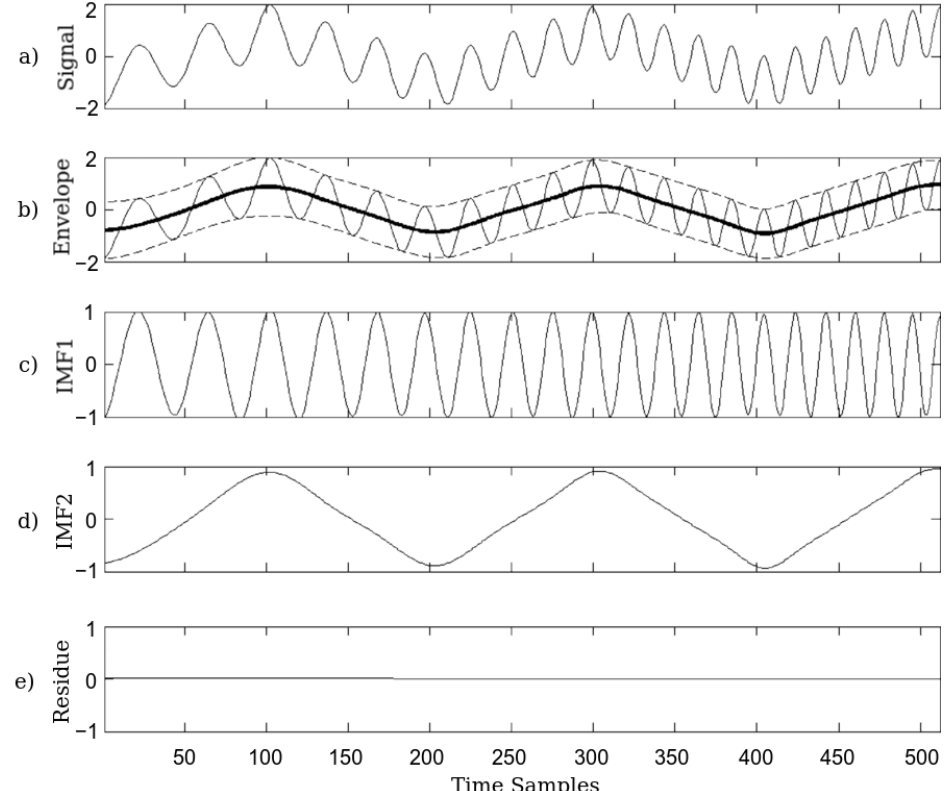
Figure 2. Example [52] of EMD on a synthetic signal ( a ), which was constructed by summing a sinusoid and triangle signal. Quartic splines are calculated to form the dotted-line envelope in ( b ). Then first recursive EMD sifting process produces the first IMF in ( c ), and then afterwards a second in ( d ). Remaining is the residual in ( e ). In this example the residual is exactly zero so the decomposition is